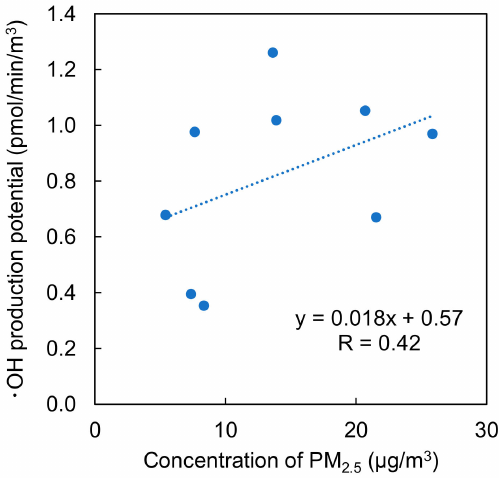
Figure 3. Relationship between concentration and · OH production potential of PM 2.5 . The samples were collected in Kanagawa, Japan, from August to November